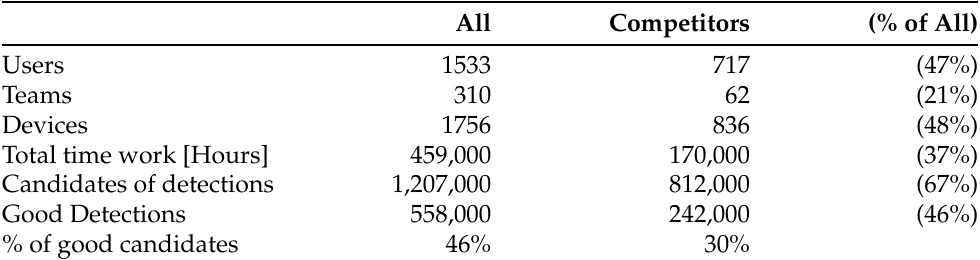
Table 1. All participants vs. competition participants. Data collected from 1 October 2019